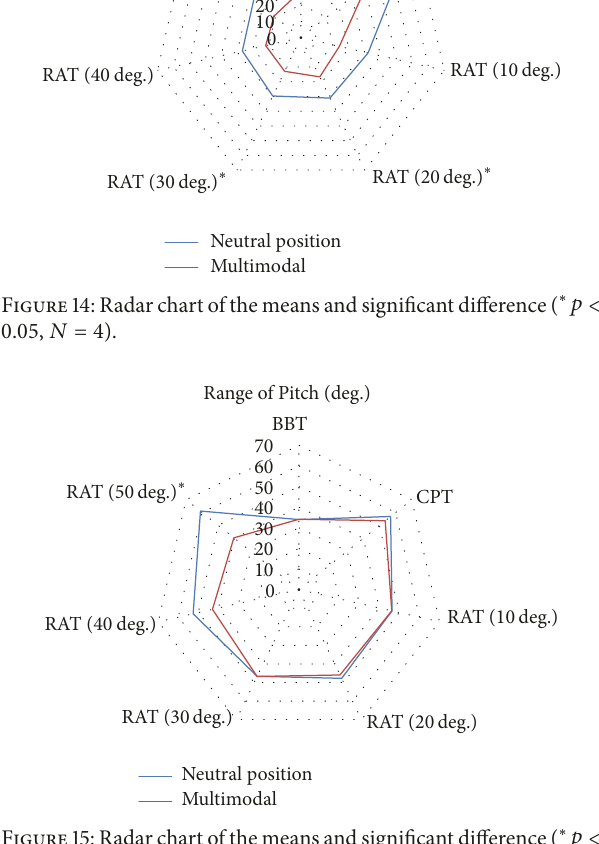
Figure 15: Radar chart of the means and significant difference ( ∗ 𝑝 < 0.05 , 𝑁 = 4 ).